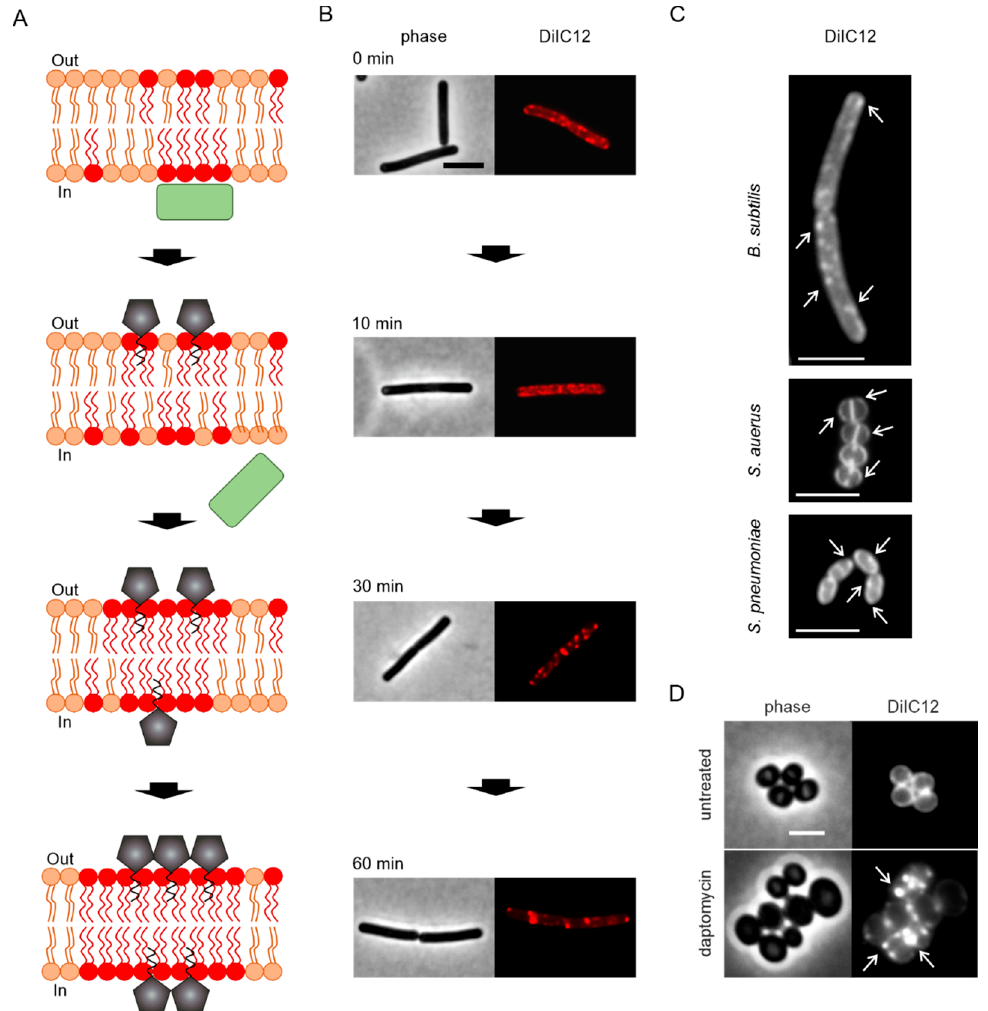
Figure 3. New in vivo model of daptomycin action. ( A ) Molecular model of membrane interaction and protein delocalization. Adapted from [54]. ( B ) Corresponding microscopy pictures showing phase contrast and DiIC12 fluorescence. DiIC12 is a fluid lipid domain dye that visualizes regions of increased fluidity (RIFs) in both Gram-positive and Gram-negative bacteria [96,97]. Images were previously published in [54]. ( C ) Fluid membrane domains (indicated by arrows) stained with DiIC12 in different Gram-positive bacteria: B. subtilis , S. aureus , and Streptococcus pneumoniae . Images were previously published in [98]. ( D ) Accumulation of fluid membrane domains (arrows) by daptomycin in S. aureus . Scale bars: 2 µm.